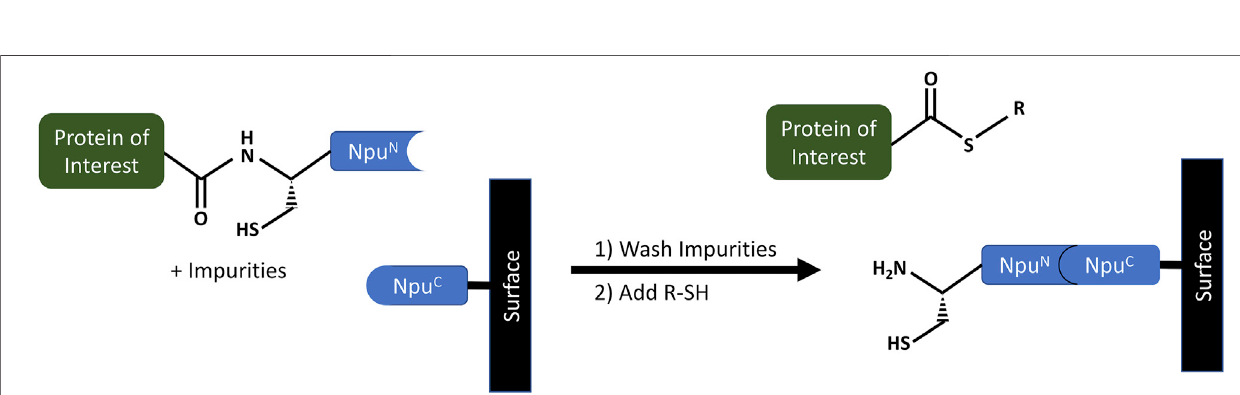
FIGURE 6 | Comparison of the Split Intein mediated ultra-Rapid Puri fi cation system (SIRP) developed by scientists at Texas A&M University (Chen et al., 2018; PatentNo.:US10087213B2;prioritizedin2013, fi ledin2014andgrantedin2018)vsalreadyexistingintein-basedcleavingmethodatthattime,whichwasusedinlabs (Guan et al., 2013; Guan & Chen, 2017; Wood et al., 1999).